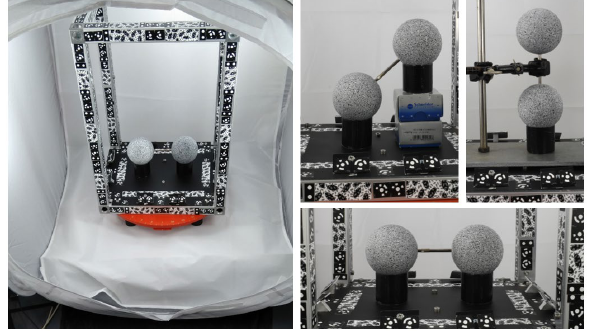
Figure 2. Light tent and used dumbbell positions